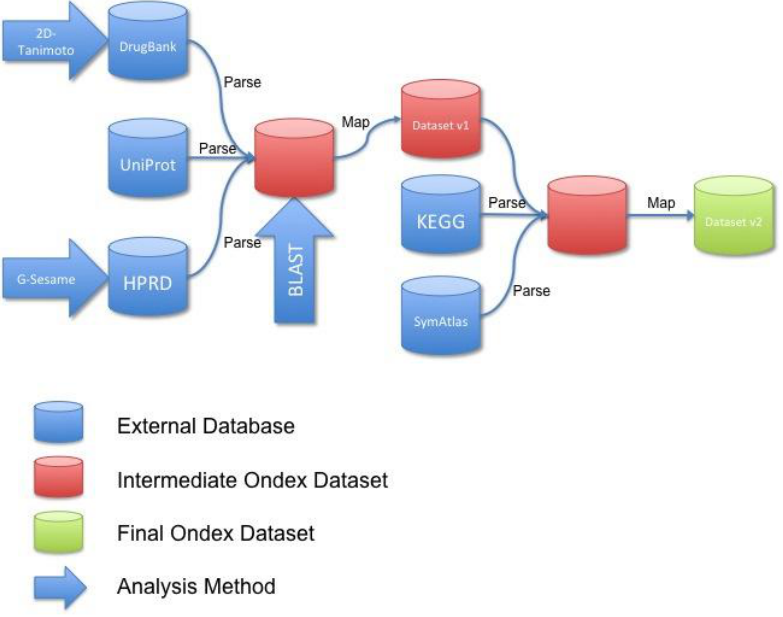
Figure 1: The Ondex data integration workflow used to generate the data for this study. Heterogeneous data sources are parsed into Ondex OXL format, and mappers and transformers applied to create new relations between